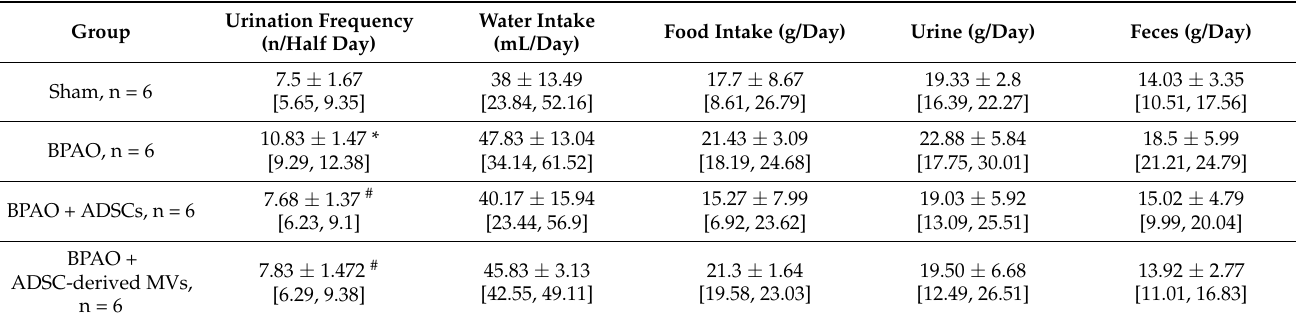
Table 1. Detailed data of behavior parameters among groups on metabolic cage study. Data are presented as mean ± standard deviation; the 95% confidence intervals are shown in brackets. * p < 0.05 vs. sham group by two-tailed non-paired